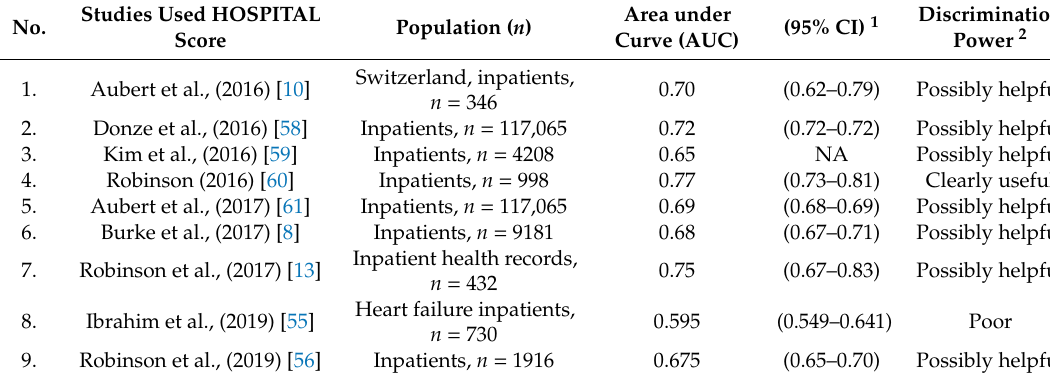
Table A4. Summary of previous studies used HOSPITAL score predictive model for readmission for di ff erent populations. Ordered according to year of